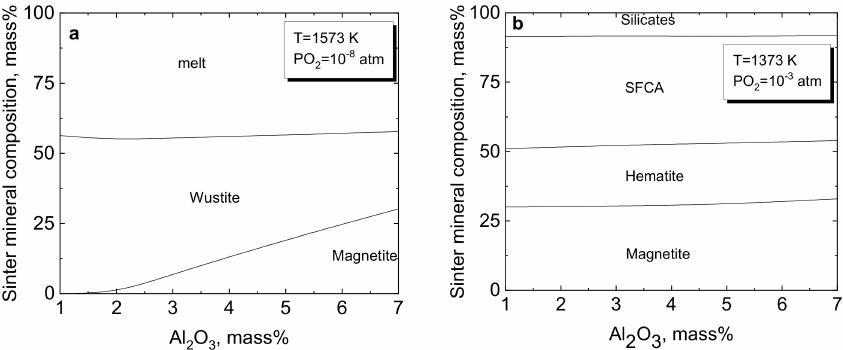
Figure 11. Mineral composition of sinter under varied Al 2 O 3 at temperature of ( a ) 1573 and ( b ) 1373